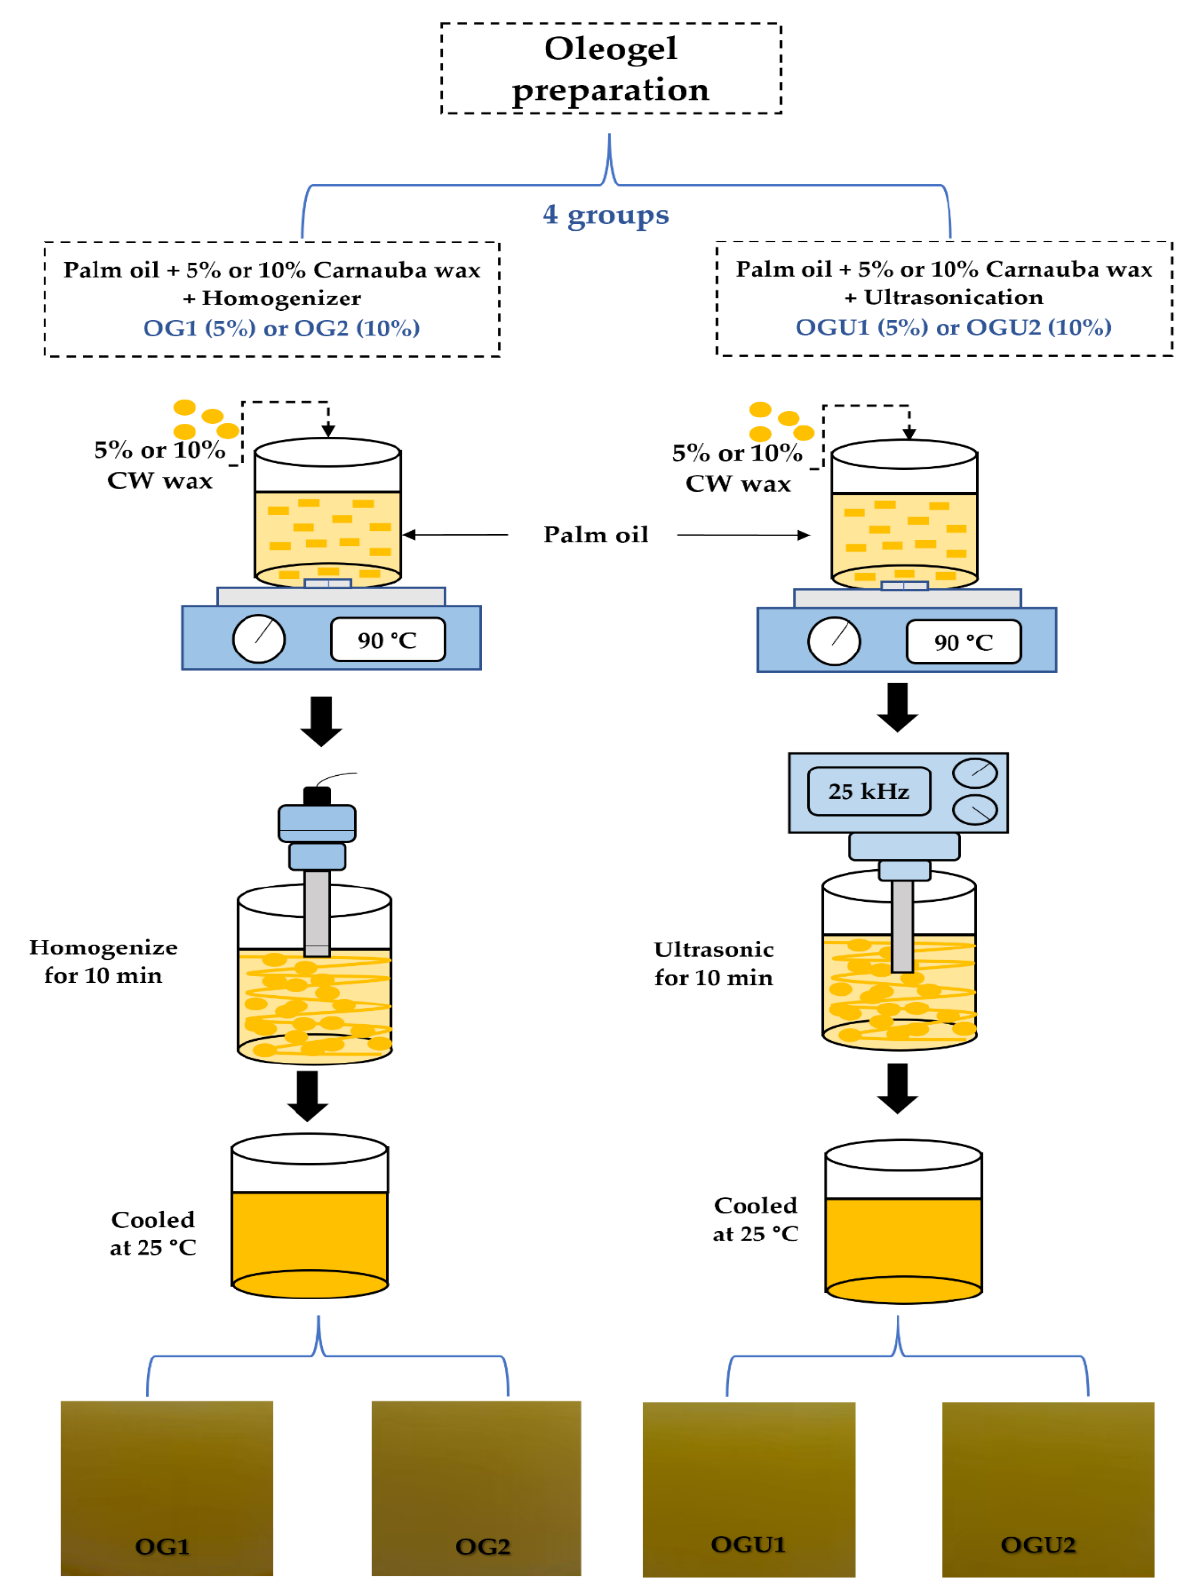
Figure 8. Infographic presentation of palm oil-based oleogel prepared with different CW concentra- tions and the ultrasonication process.